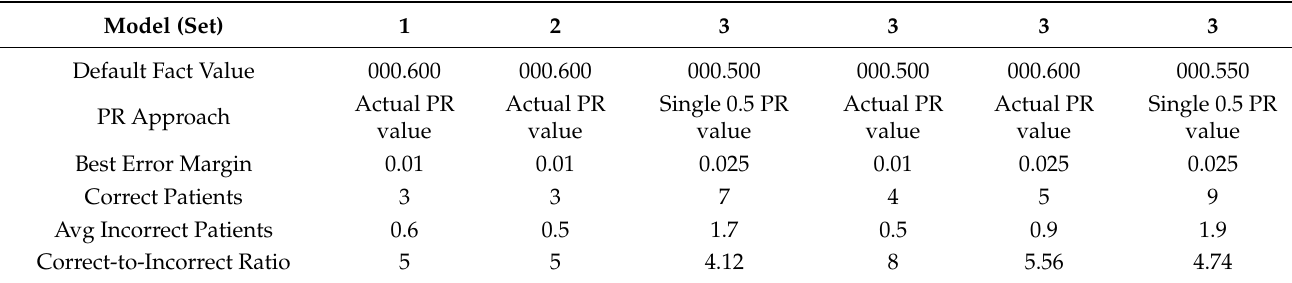
Table 12. Summary of standout